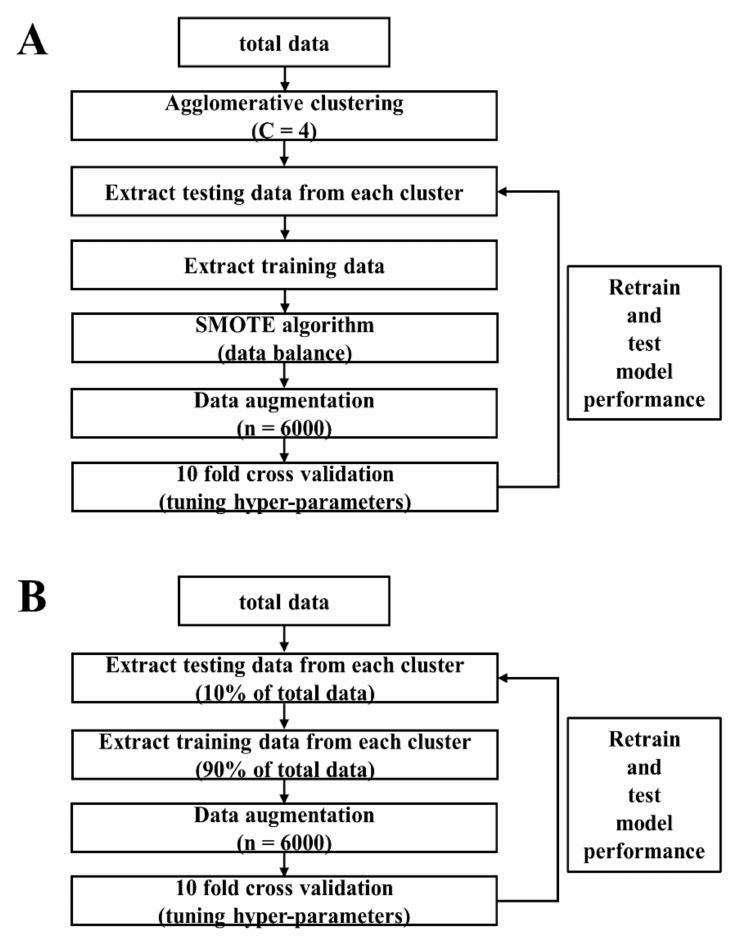
Figure 2. ( A ) The overview of SEM modules’ training and testing procedure; ( B ) The overview of PV modules’ training and testing procedure. SEM: suggested exercise mode. PV: predicted value of rest HR difference after following suggested exercise